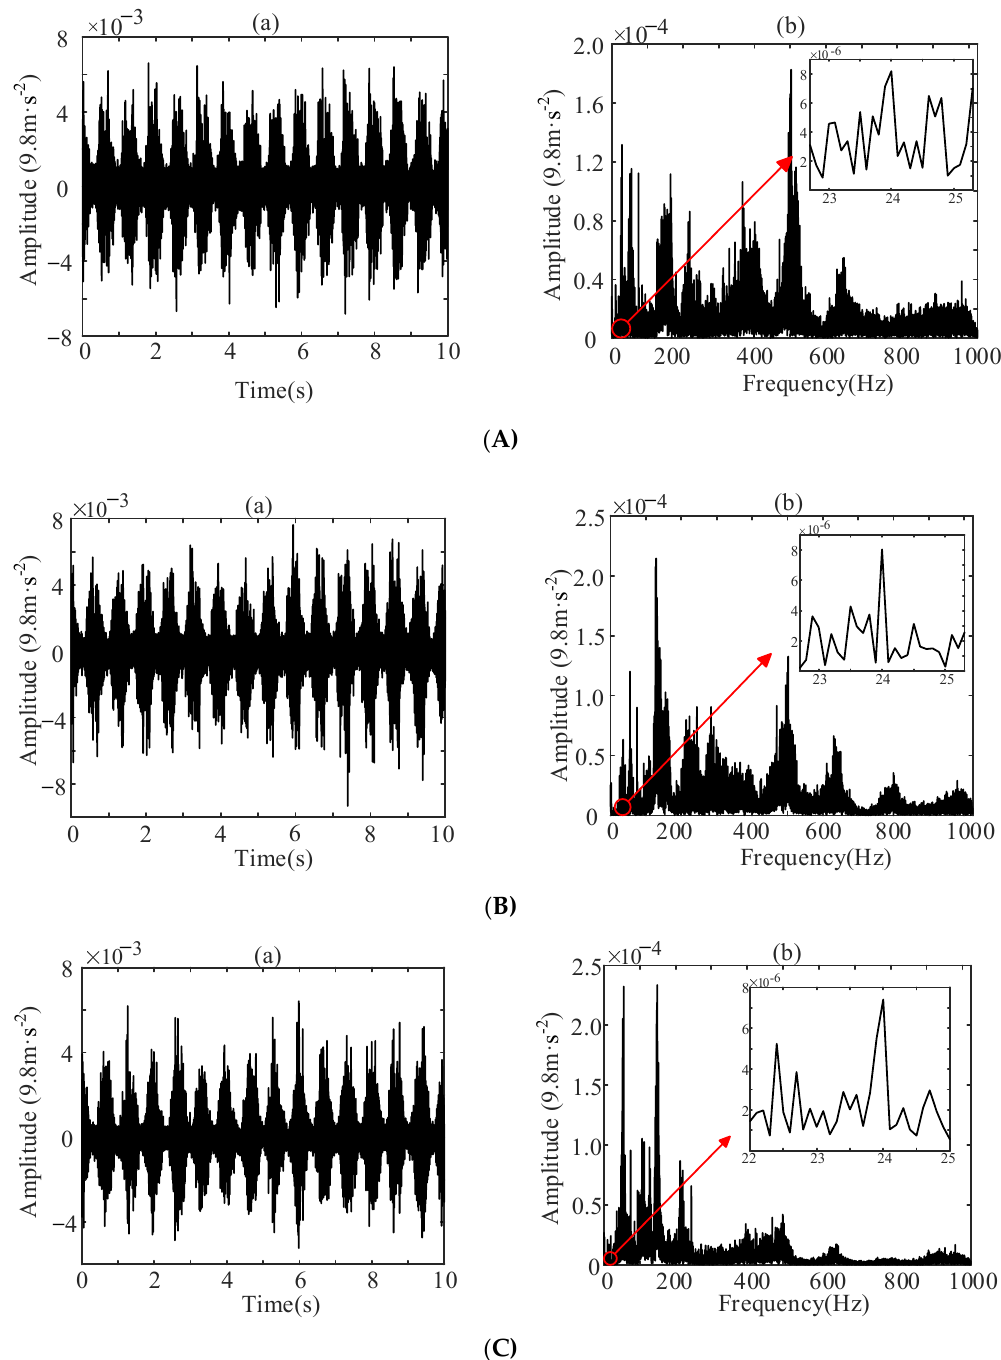
Figure 8. The time domain waveforms and frequency spectrum of the bearing vibration signal under the linear alignment state: ( A ) Intermediate bearing; ( B ) Front stern bearing; ( C ) Aft stern bearing.